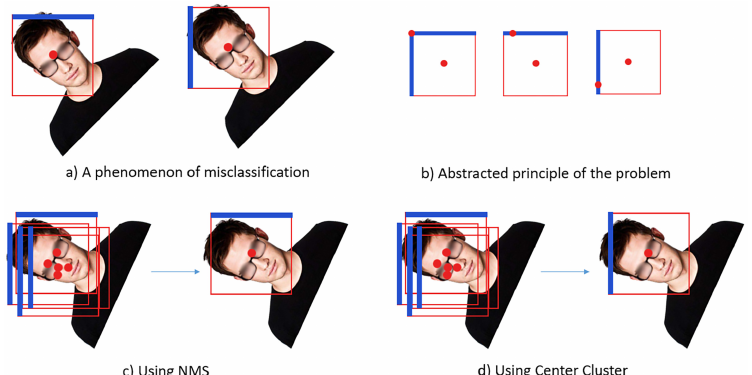
Figure 2. ( a ) Phenomenon of misclassification under a boundary where the blue line represents the upright orientation predicted by the detector and the red point represents the center of the bounding box. ( b ) The red point on the border represents the true orientation of the face. ( c ) The surrounding bounding boxes’ information is ignored when using non-maximum suppression (NMS) method. ( d ) The surrounding bounding boxes’ information, captured by